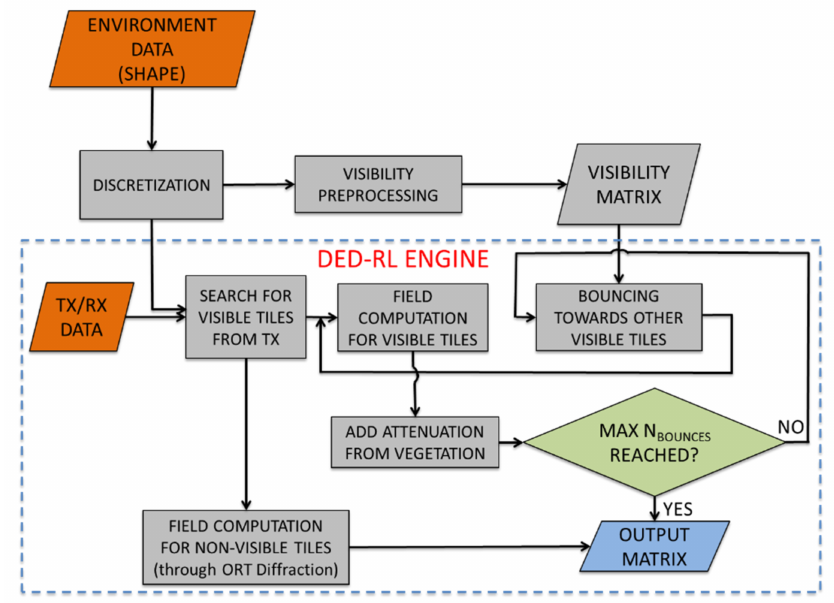
Figure 3. Simplified scheme and computation flow of the DED-RL